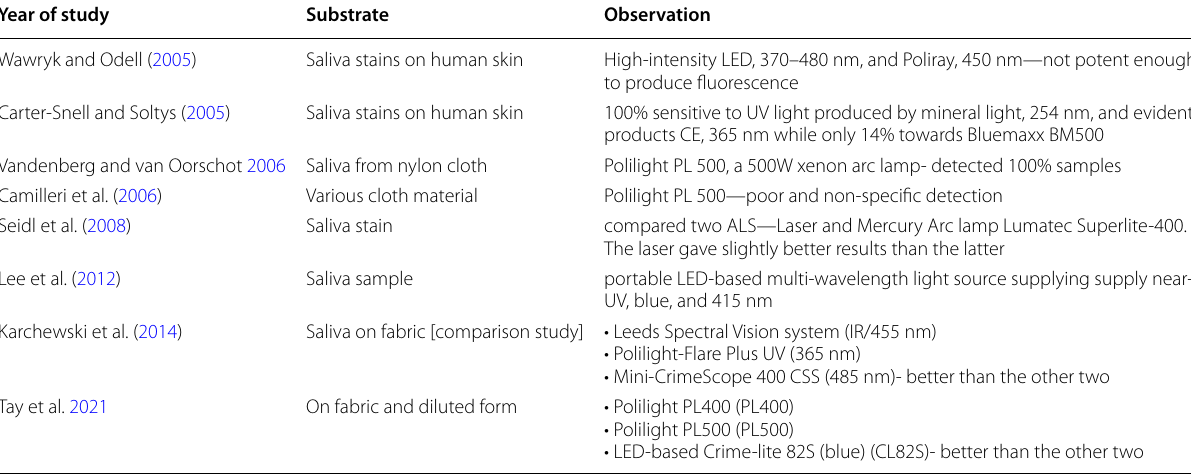
Table 1 Various studies on polilight detection of saliva Year of study